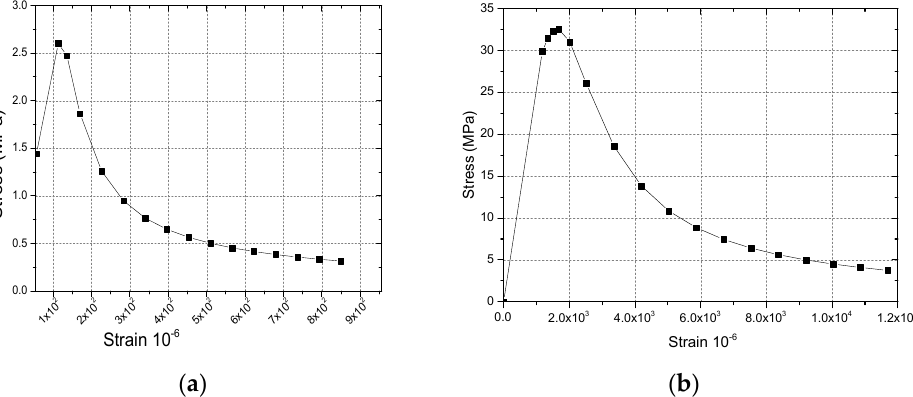
Figure 7. Plastic damage constitutive curve of concrete. ( a ) Compression damage constitutive curve of concrete. ( b )Tensile damage constitutive curve of concrete.